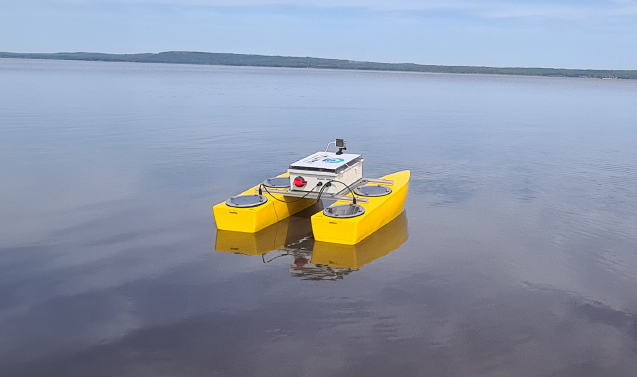
Figure 1. Example of autonomous surface vehicle for environmental